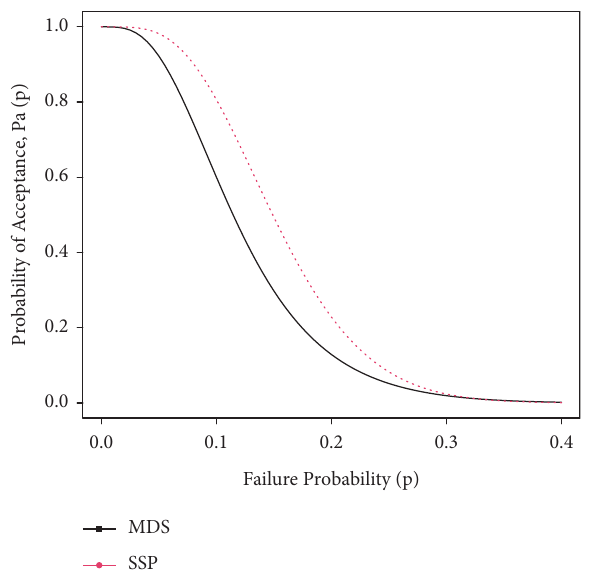
Figure 2: OC curves of MDSP and SSP